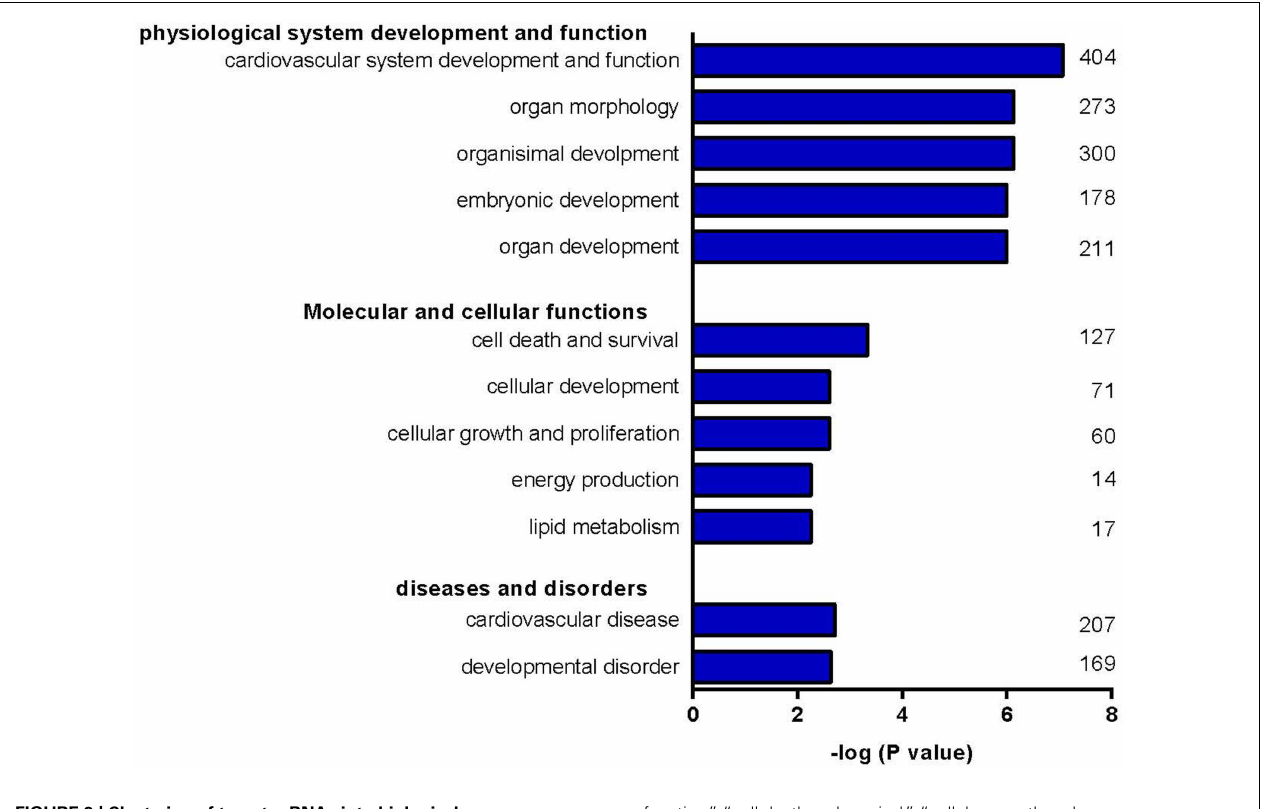
function,” “cell death and survival,” “cellular growth and proliferation,” “energy metabolism,” and “lipid metabolism.” Numbers indicate the number of target mRNAs involved in the corresponding